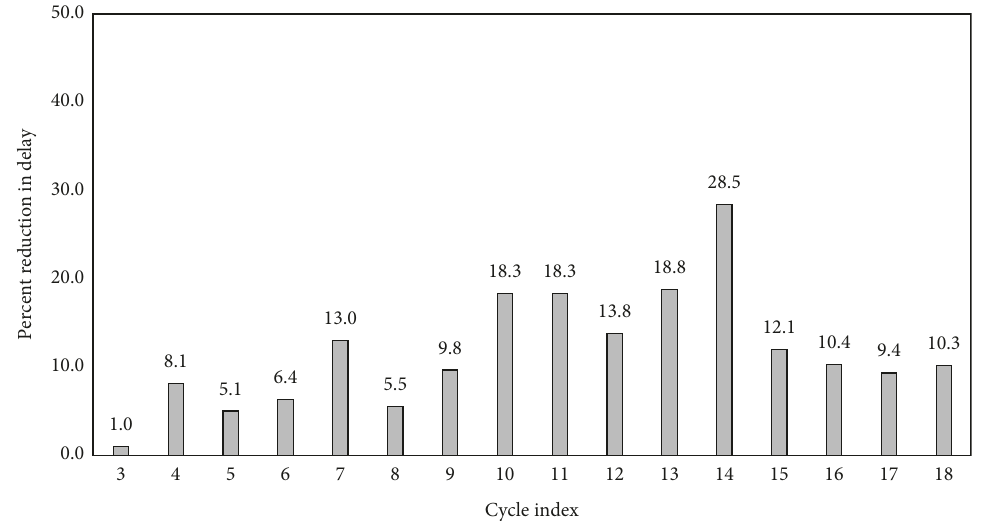
Figure 11: Theoretical comparison of total intersection delay by Model I and Webster’s signal design.